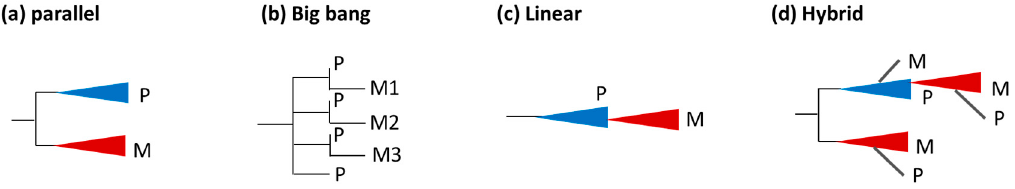
Figure 4. Progression models and the shapes of phylogenies. Expected shapes of phylogenies of tumors (P: primary and M: metastatic) for ( a ) parallel, ( b ) “big bang”, ( c ) linear, and ( d ) hybrid models.